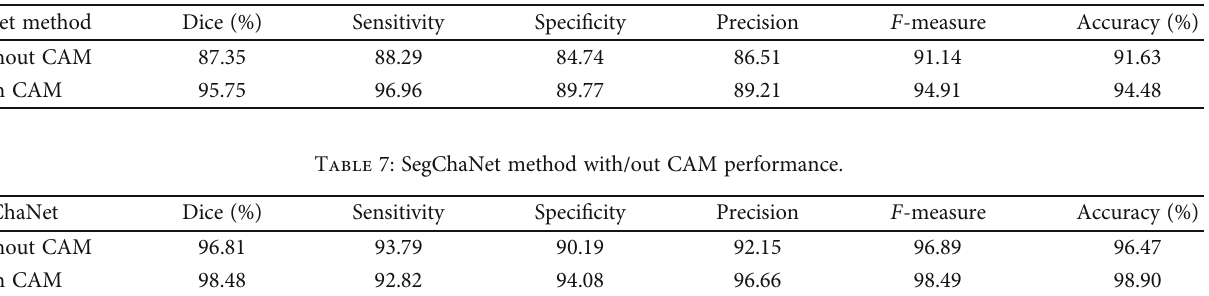
Table 6: The V-Net method with/out CAM performance.